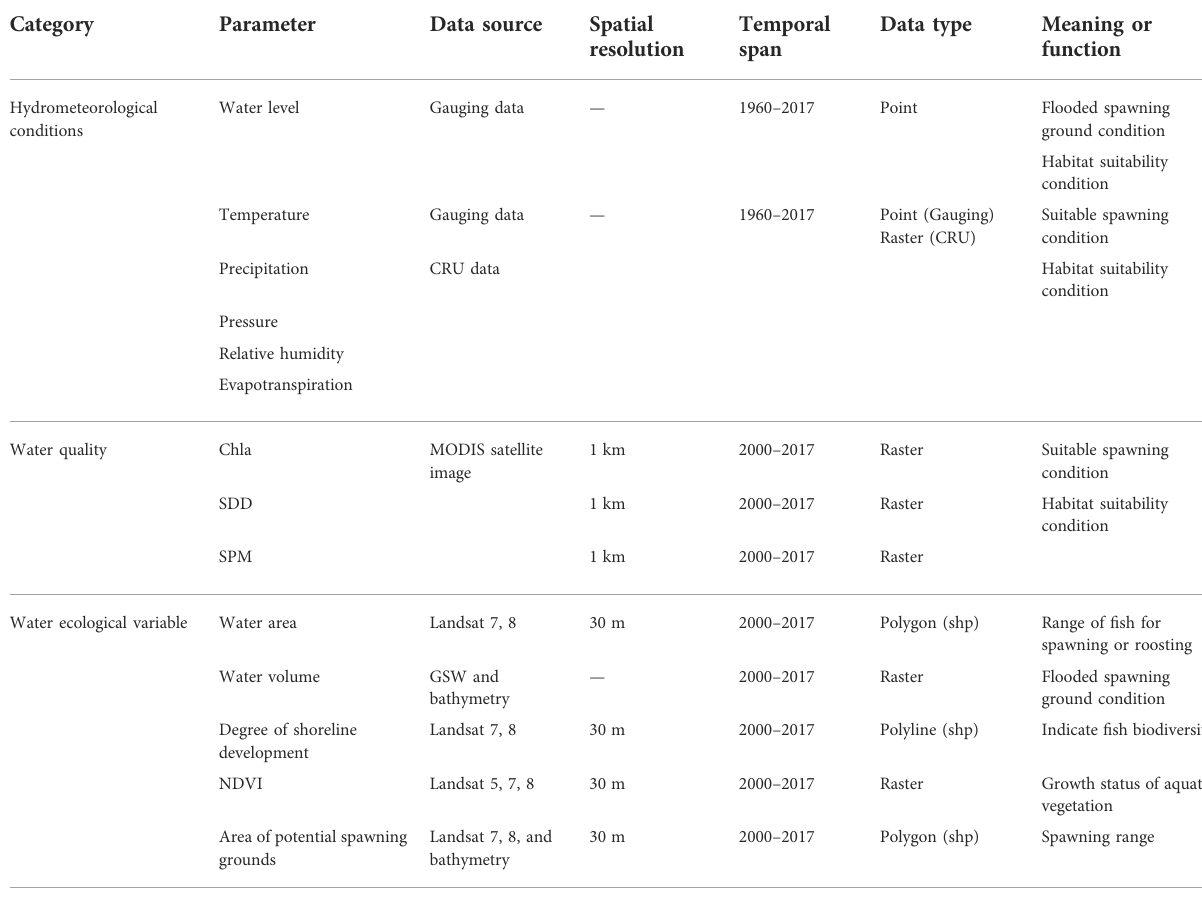
TABLE 2 List of environmental variables involved in the machine learning